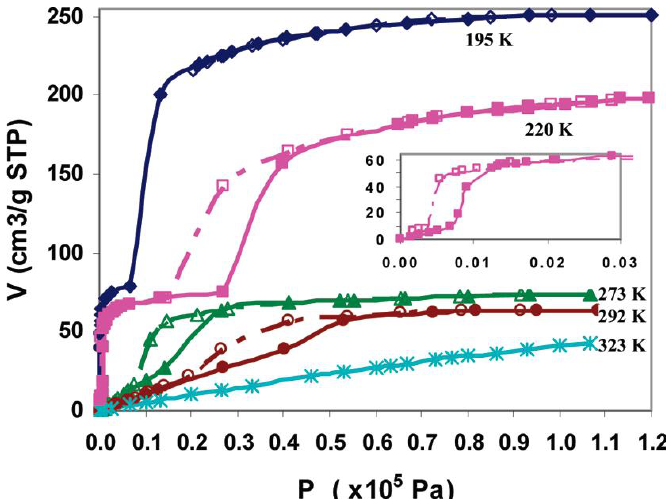
Figure 17. Xe adsorption (solid symbols) and desorption (open symbols) isotherms measured at 195 (lozenges), 220 (squares), 273 (triangles), 292 (circles), and 323 K (stars). Inset: Low-pressure region of the isotherm at 220 K. Reprinted with permission from [110]. Copyright 2010 American Chemical